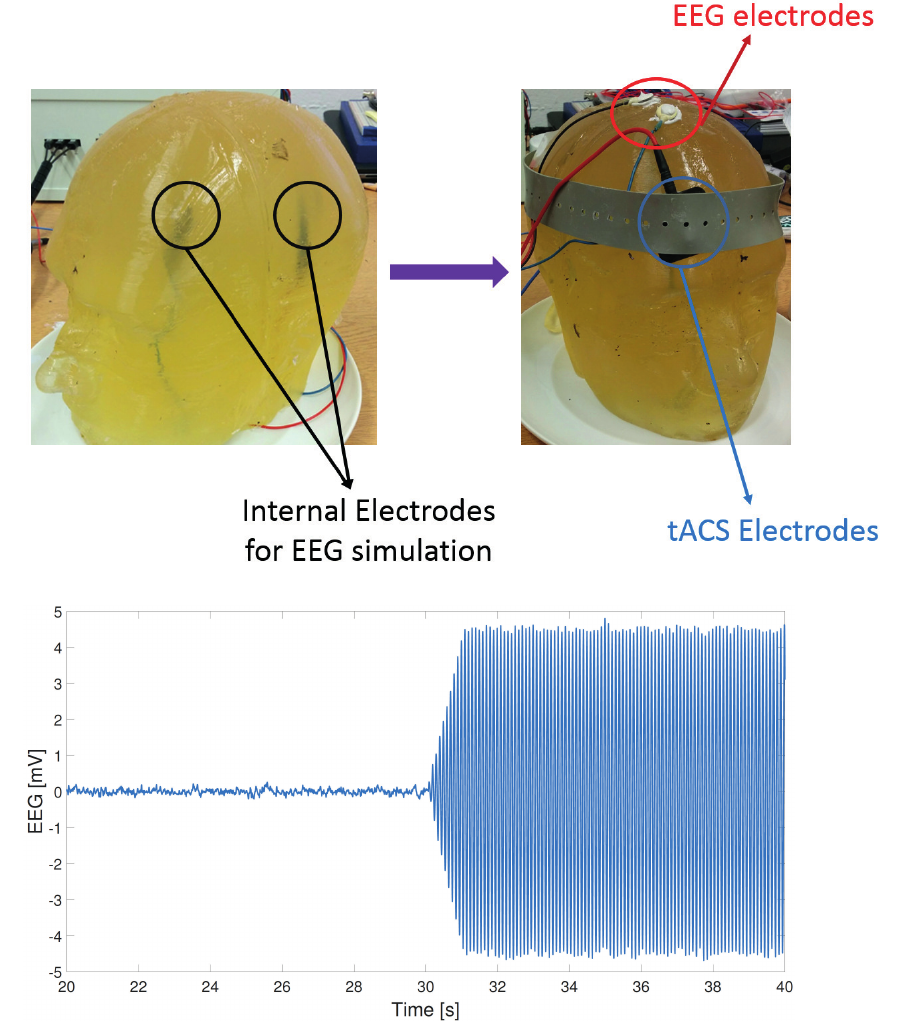
Figure 4. Gelatin phantom head model. ( Top ) internal electrodes for generating EEG signal, with tACS and EEG electrodes placed on the surface. ( Bottom ) Recorded EEG after 10 Hz, 1 mA tACS starts at time 30 s. Here a 1 s ramp up is included in the stimulation